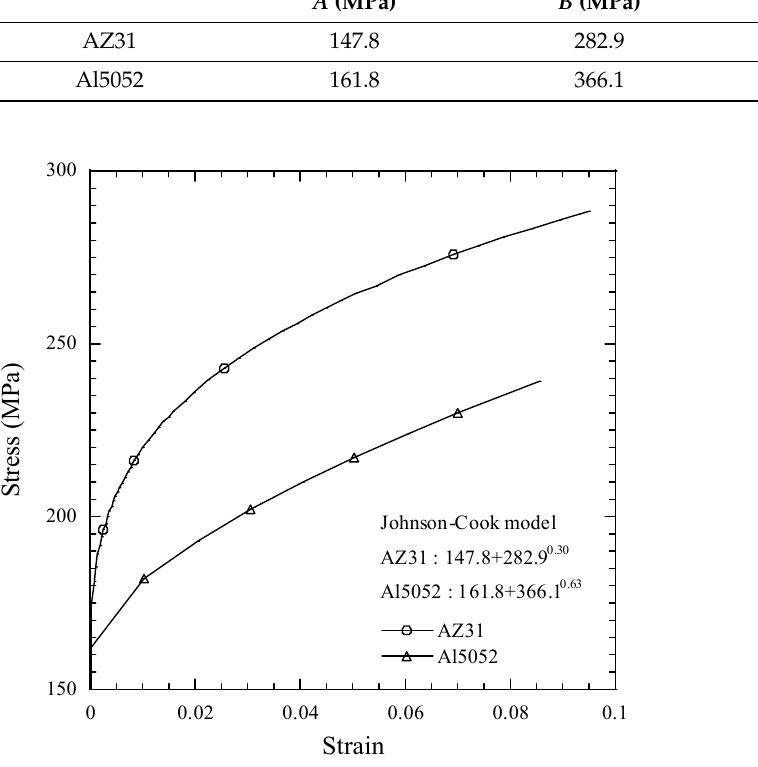
Figure 5. Stress-strain curves of AZ31 and Al5052 alloys with the Johnson–cook deformation model.